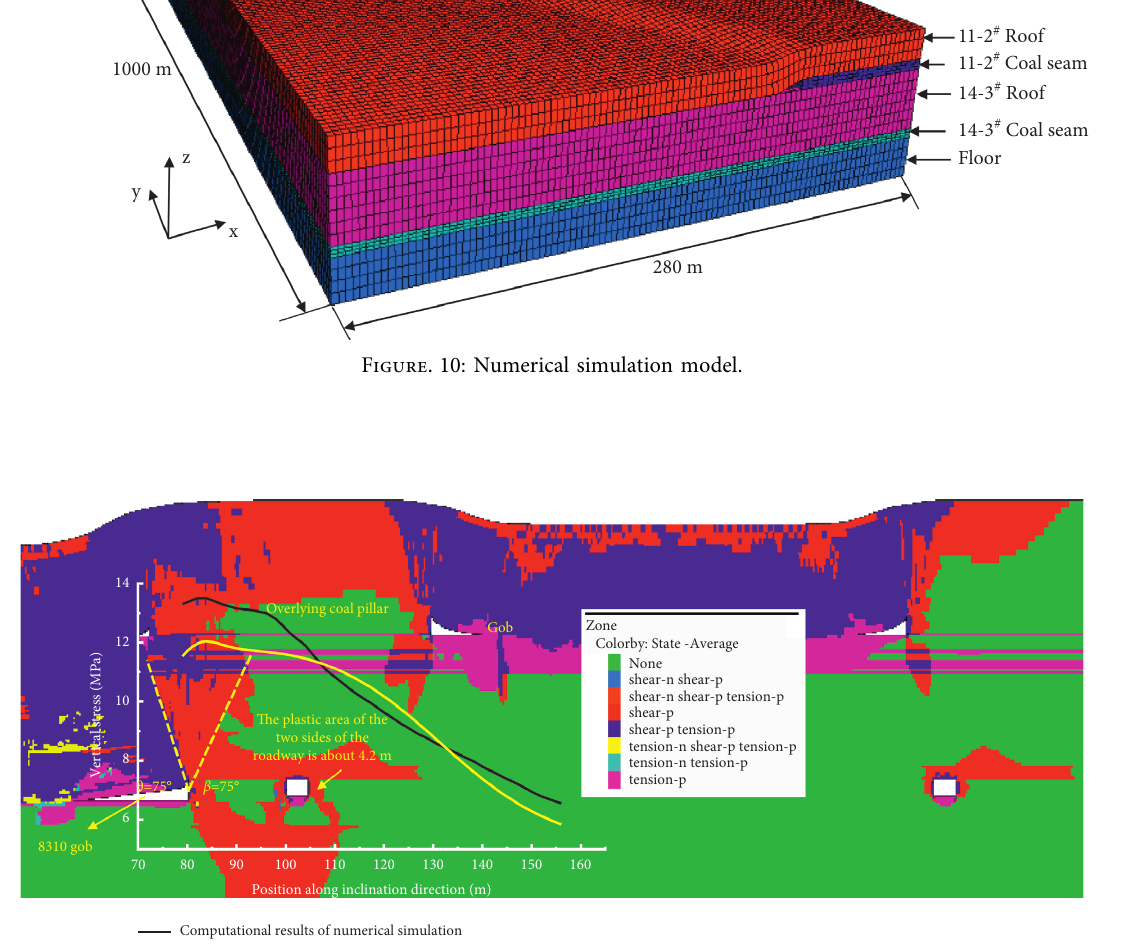
Figure 11: Plastic zone and vertical stress distribution on both sides of the gob-side roadway at Section